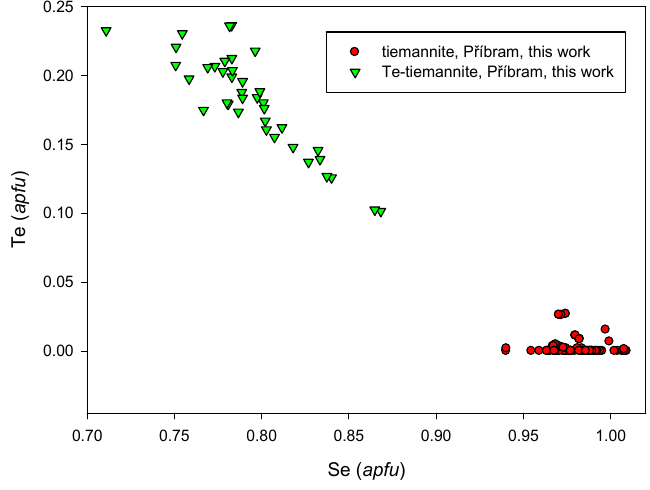
Figure 73. Se vs. Te (in apfu ) graph for tiemannite and Te-rich tiemannite from P ř íbram.